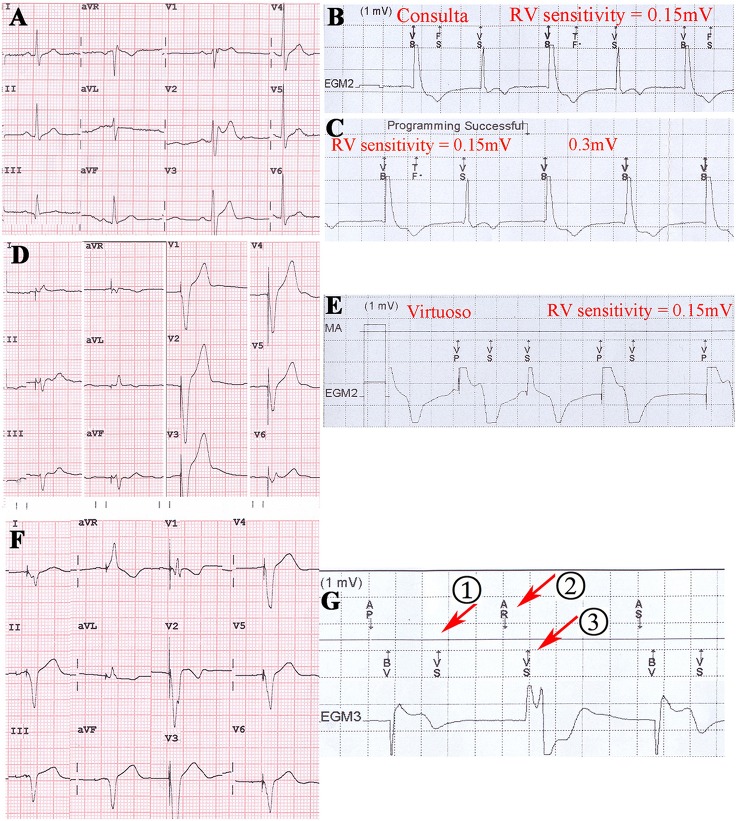
Post pacing TWOS revealed during the procedure of ICD implantation in Brugada syndrome patient, hypertrophic cardiomyopathy patient and dialated cardiomyopathy patient. (A) 12-lead surface EKG of a Brugada syndrome patient. (B,C) Post pacing TWOS episodes by a Consulta ICD under sensitivity of 0.15 mV. No TWOS was recorded under 0.3 mV. (D) 12-lead surface EKG of a hypertrophic cardiomyopathy patient. The implantable cardioverter-defibrillator working mode is VAT. (E) Post pacing TWOS episodes in Virtuoso ICD under the sensitivity of 0.15 mV. (F) 12-lead EKG of a CRT-D patient with dilated cardiomyopathy. (G) After the episode of TWOS (①), PVARP was prolonged by PVC response and sinus P wave was recognized as a premature beat (②) and not traced by ventricle (③).